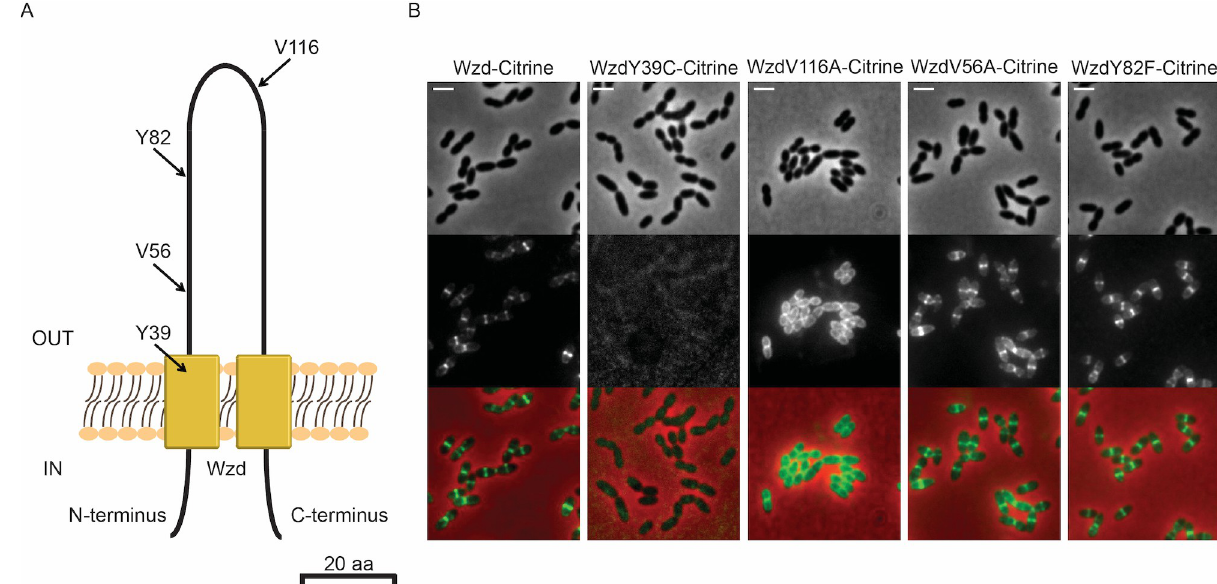
Fig 4. Point mutations in Wzd affect its localization. A) Scheme of Wzd protein indicating the localization, in the extracellular loop, of four mutations that were associated with a mucoid colony phenotype [19]. B) Localization of Citrine fluorescent derivatives of Wzd single-residue mutants expressed in a wzd null mutant strain. Strain BCSMH022, expressing Wzd-Citrine was used as control. V56A and Y82F mutations did not interfere with the ability of Wzd to localize at the division septum upon interaction with Wze. Representative phase contrast (top panels, for visualization of bacteria), fluorescence microscopy (middle panels, for detection of the capsule associated with the bacterial cell surface) and overlay (bottom panels) images of each strain are shown. Scale bar, 2 μ m.